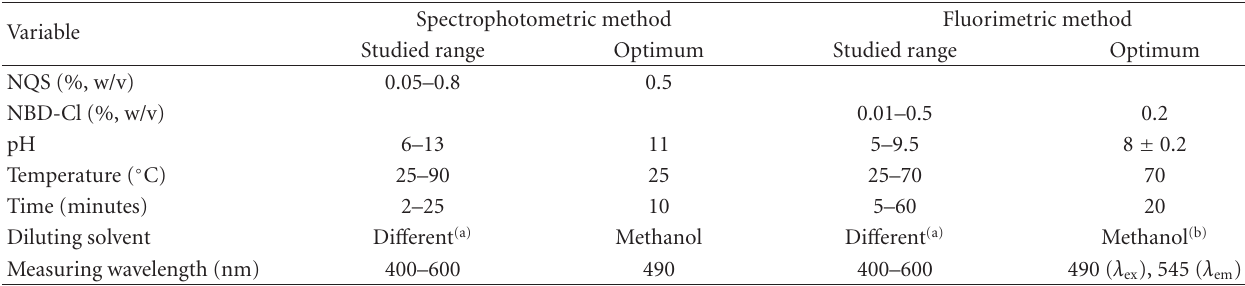
Table 1: Summary for the optimization of variables a ff ecting the reaction of FLX with NQS and NBD-Cl reagents employed in the development of the proposed spectrophotometric and fluorimetric methods, respectively.